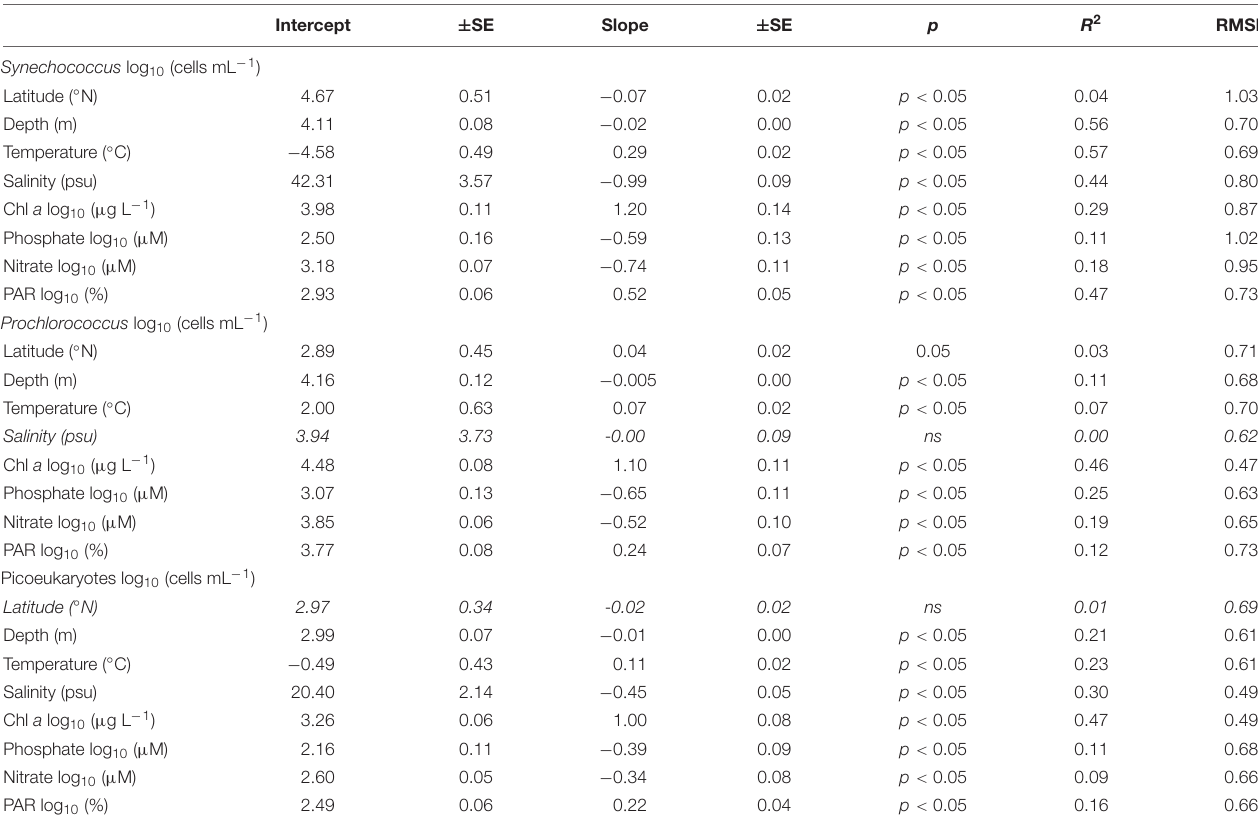
TABLE 2 | Summary of the linear relationships between Synechococcus , Prochlorococcus , and picoeukaryote abundances (log 10 cells mL − 1 ) with latitude, depth, and the different environmental parameters measured in the Red Sea. Intercept ± SE Slope ±